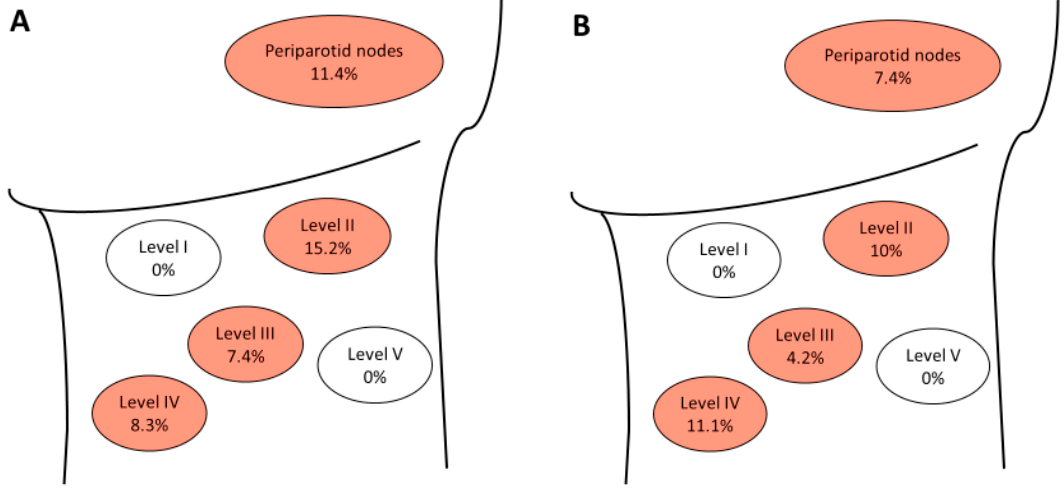
Figure 1. Distribution of locoregional lymph node metastases. Positive neck nodes of all patients ( n = 35) undergoing neck dissection ( A ) and distribution of occult metastases ( n = 27) in the neck after elective neck dissection ( B ). Levels I–V: percentage of involved nodes at that